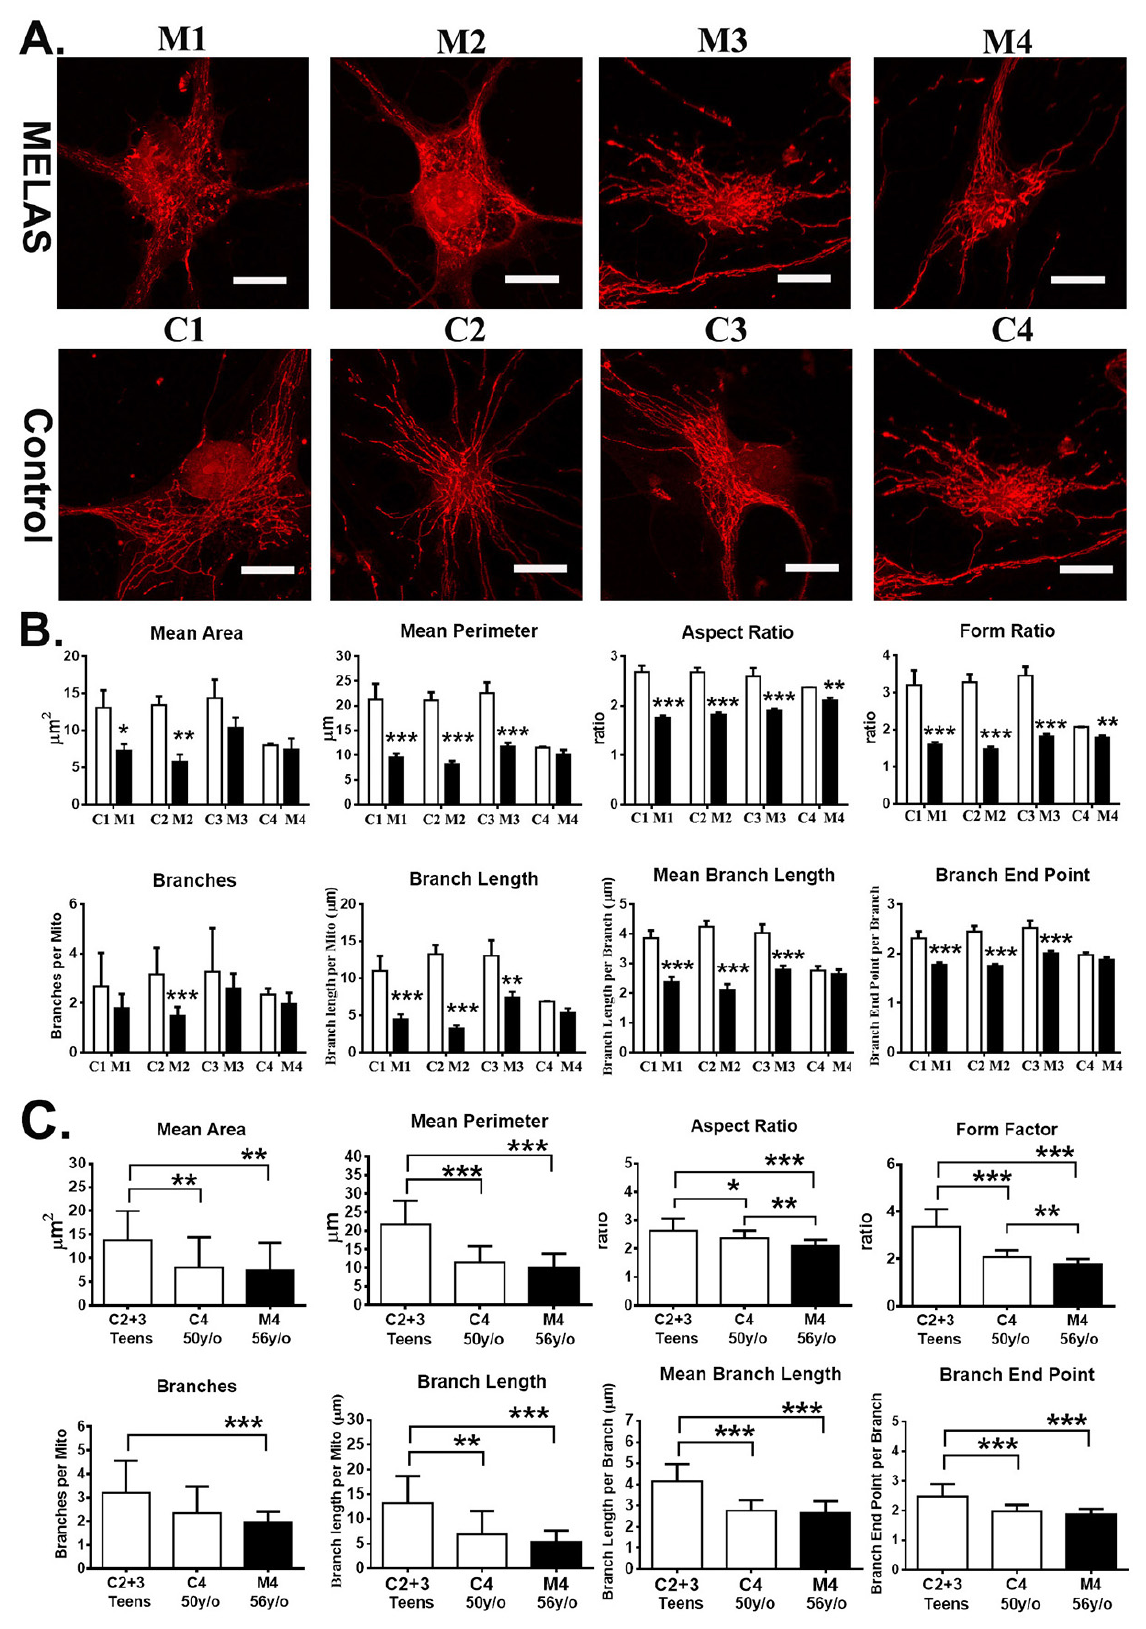
Figure 7. Alternation of mitochondrial dynamics in MELAS iNs. ( A ) Representative image of mitochondrial morphology in iNs staining with MitoTracker ® Red CMXRos. ( B ) Quantitative